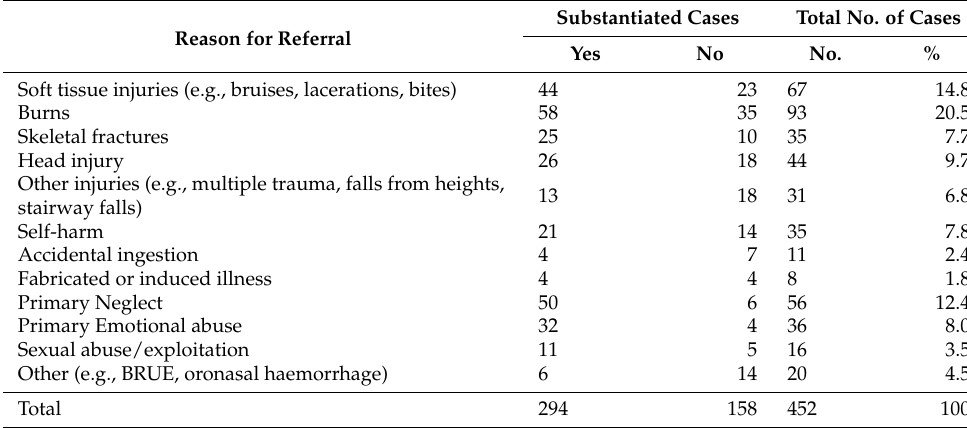
Table 3. Referral characteristics of the